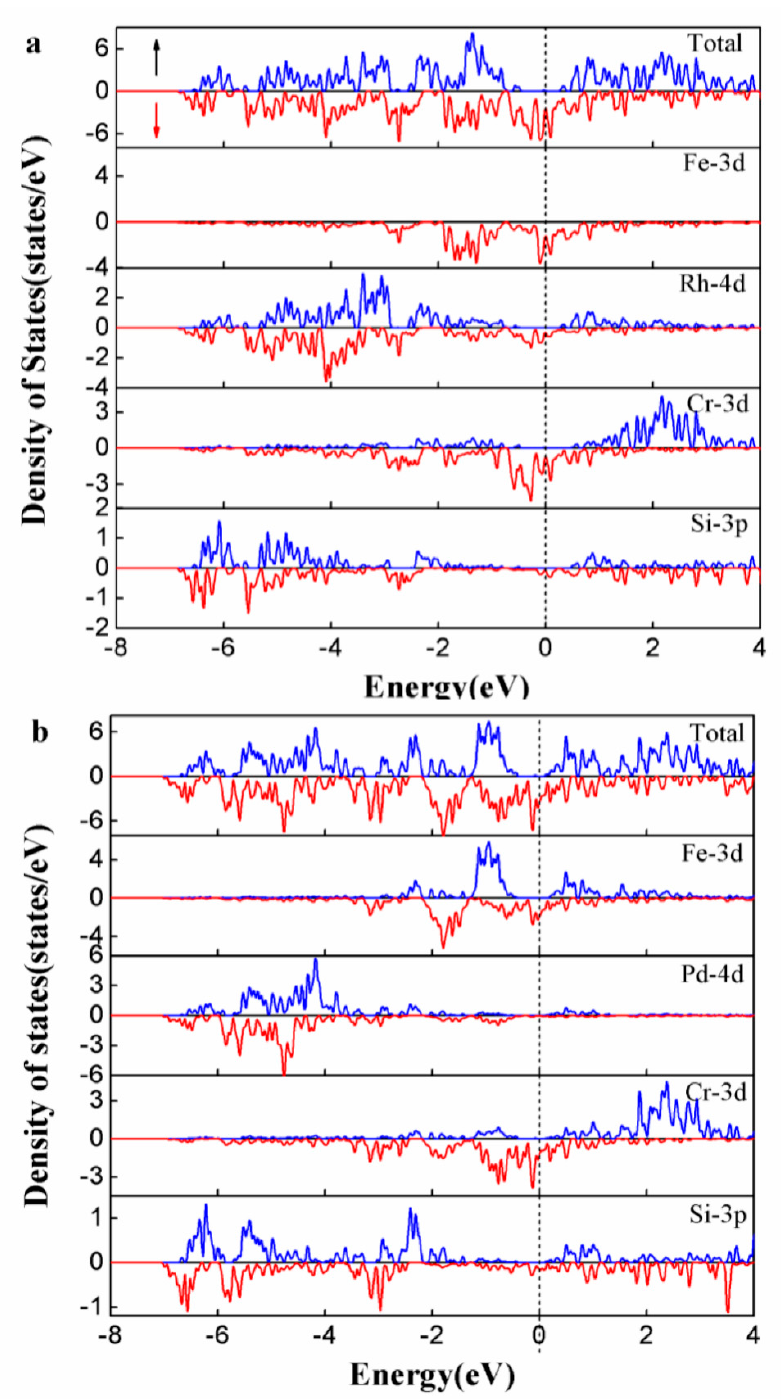
Figure 5. The total and partial density of states of ( a ) FeRhCrSi and ( b ) FePdCrSi at their equilibrium lattice